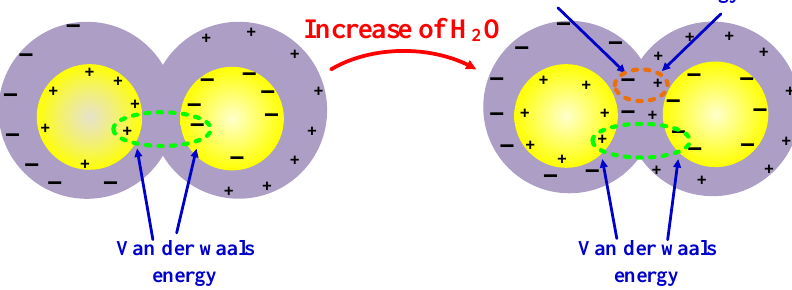
Figure 7. A schematic summarizing the variation of the intermolecular interaction energy.